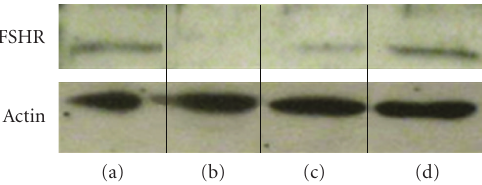
Figure 4: The expression of FSH-R protein in (a) the testis, (b) skeletal muscle of rat, (c) the caput epididymis, and (d) the cauda epididymis. The presence of actin in tested tissues of rat is shown.